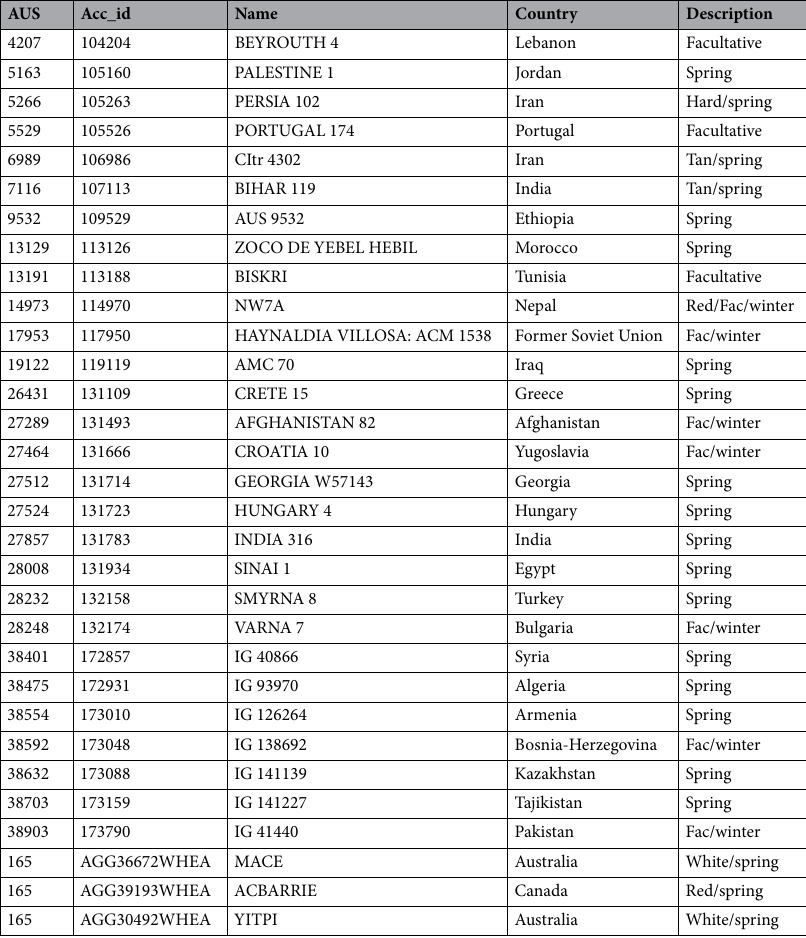
Table 1. Description of the wheat landraces and the commercial cultivars used in this